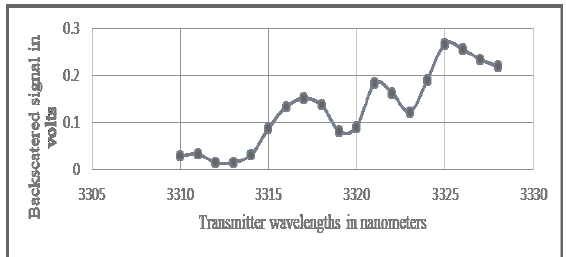
Fig.1: Backscattered signal intensity as a function